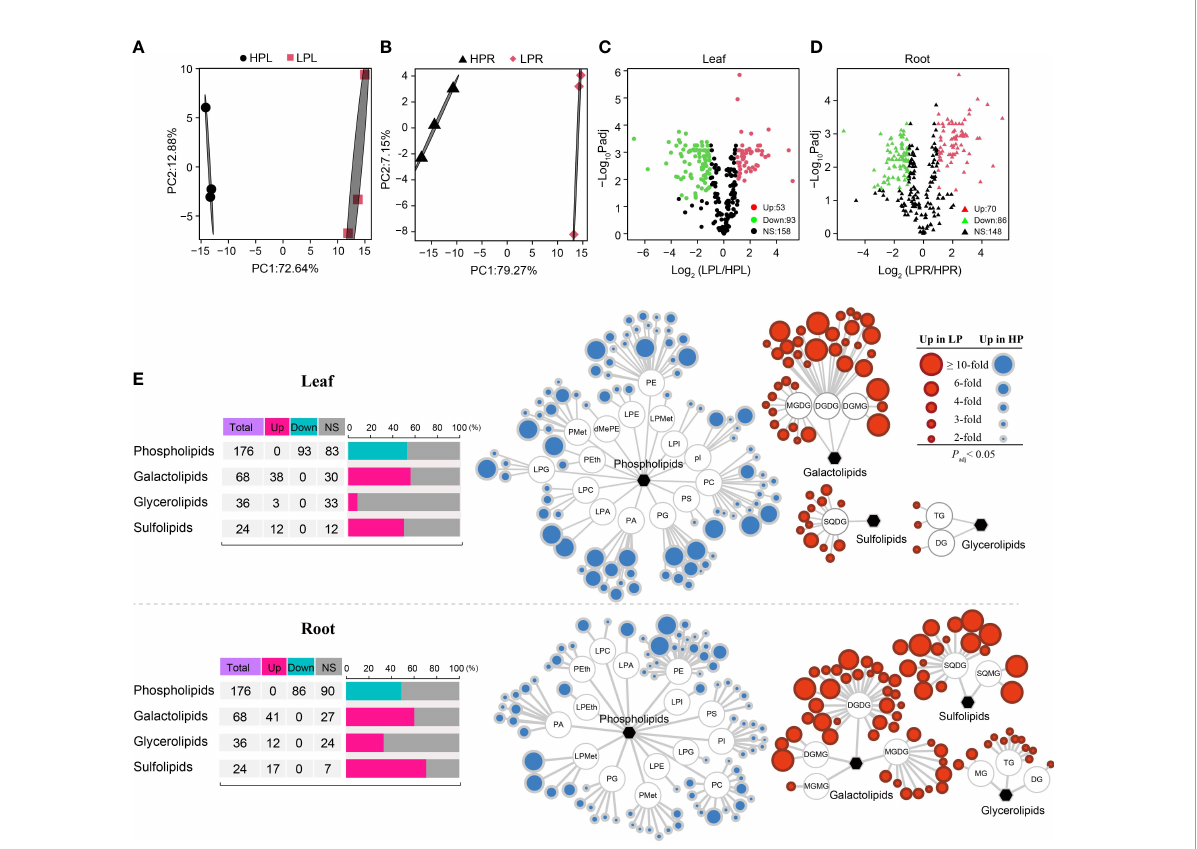
FIGURE 4 Analysis of lipid metabolome in elephant grass leaves and roots upon Pi starvation. (A, B) Principal component analysis of all lipid metabolites in elephant grass leaves (A) and roots (B) . (C, D) Volcano diagrams of lipids in Pi-de fi cient leaves (C) and roots (D) of elephant grass. (E) Statistic classi fi cation and pro fi le of differentially expressed lipids in Pi-de fi cient leaves and roots. DGDG, digalactosyldiacylglycerol; MGDG, monogalactosyldiacylglycerol; DGMG, digalactosylmonoacylglycerol; MGMG, monogalactosylmonoacylglycerol; SQDG, sulfoquinovosyldiacylglycerol; SQMG, sulfoquinovosylmonoacylglycerol; TG, triglyceride; DG, diglyceride; MG, monoglyceride; PG, phosphatidylglycerol; PI, phosphatidylinositol; PA, phosphatidic acid; PEth, phosphatidylethanol; PS, phosphatidylserine; LPMet, lyso-phosphatidylmethanol; LPG, lyso-phosphatidylglycerol; LPC, lyso- phosphatidylcholine; LPE, lyso-phosphatidylethanolamine; LPI, lyso-phosphatidylinositol; LPA, lyso-phosphatidic acid; LPEth, lyso-phosphatidylethanol; dMePE, dimethylphosphatidyethanolamine; PE, phosphatidylethanolamine; PC, phosphatidylcholine; PMet,